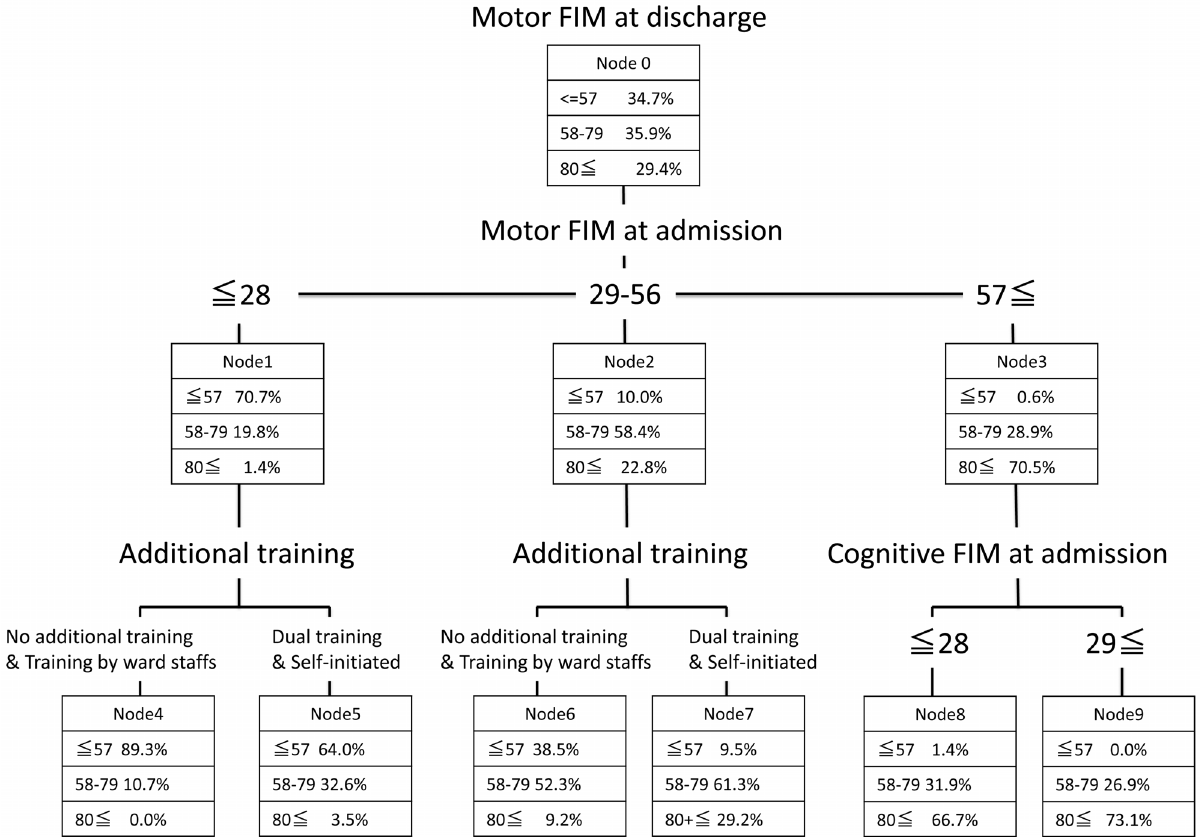
Figure 2. Decision tree for Functional Independence Measure among 1233 stroke patients (Validation Group).